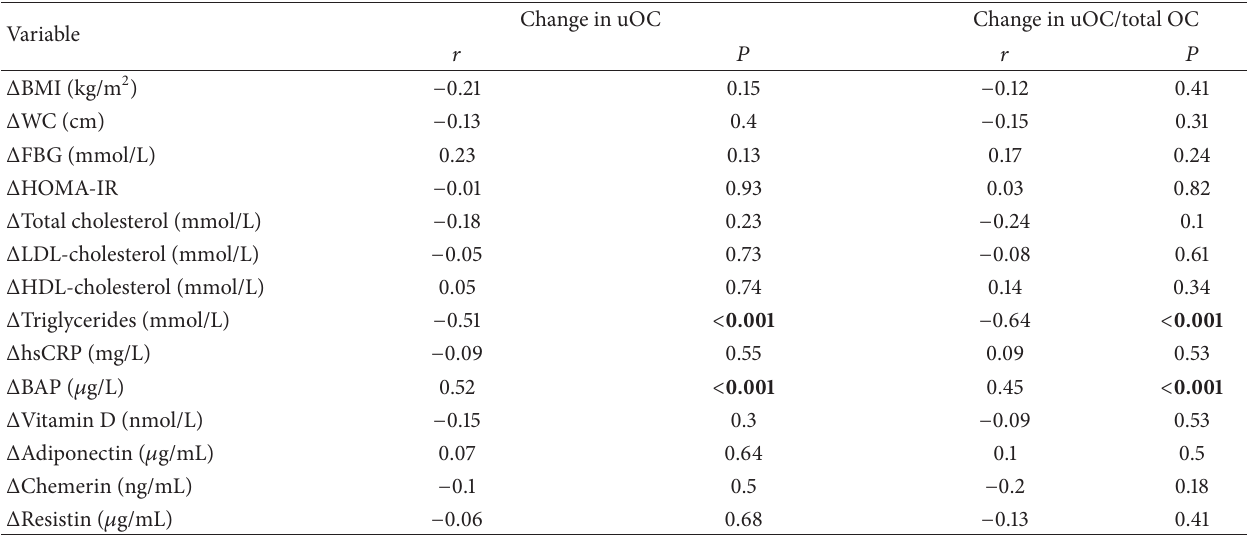
Table 2: Correlation analysis between changes in circulating undercarboxylated OC and undercarboxylated/total OC and changes in selected anthropometric and metabolic variables 4 months after dietary